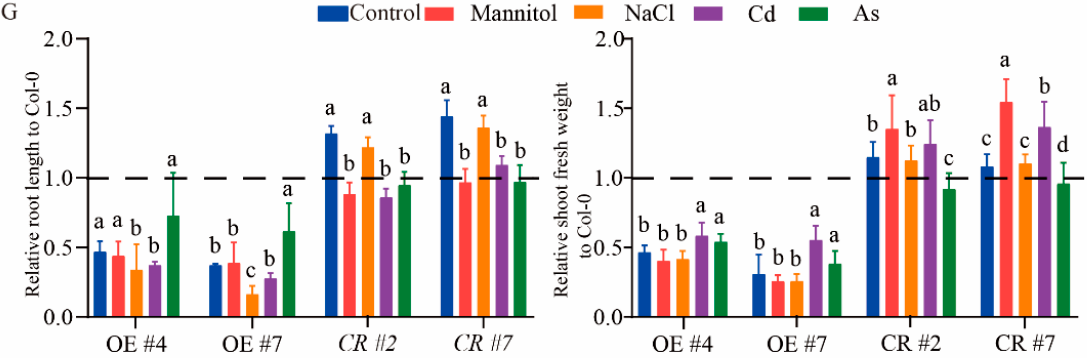
Figure 8. ERF012 reduces plant sensitivity to various abiotic stresses. ( A ) The phenotypical com- parison of Col-0, ERF012 -OE lines and erf012 mutant lines. Six-day-old seedlings grown on 1/2 MS medium were transferred to the medium with 100 mM mannitol, 100 mM NaCl, 10 µ M arsenite and 15 µ M CdCl 2 for 6 days of growth. ( B – F ) The shoot fresh weight and primary root length were statistically calculated. ( G ) The relative primary root length of Col-0 and relative shoot fresh weight of Col-0 under each stress were statistically calculated. ( B , G ) Values represent means ± SD, n = 4 pools, with 5 shoots per pool. Letters indicate significant differences between different plants: Duncan’s test ( p < 0.05). Dotted lines ( G ) indicate the relative Col-0 root length and relative Col-0 shoot fresh grown in normal conditions.